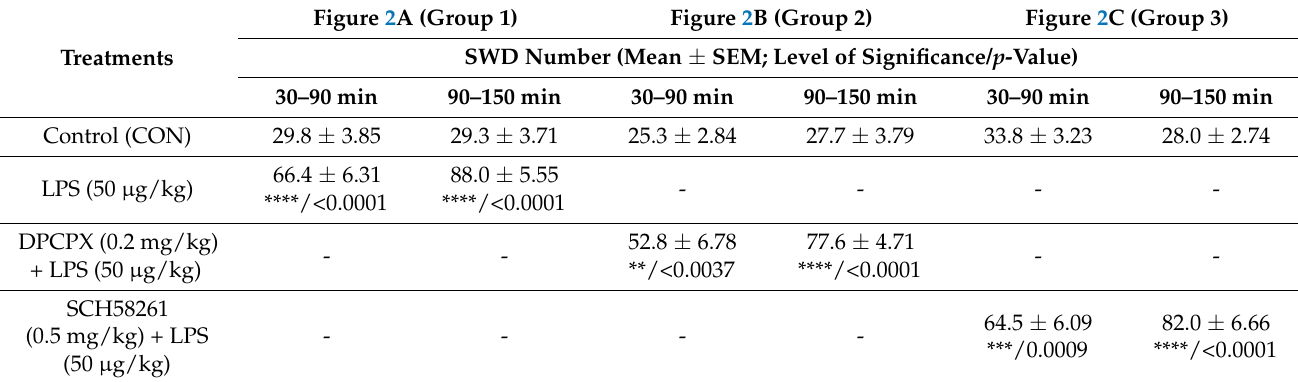
Table 1. Effect of LPS alone, and combined administration of DPCPX with LPS and SCH58261 with LPS on SWD number. Figure 2A (Group 1) Figure 2B (Group 2) Figure 2C (Group Treatments